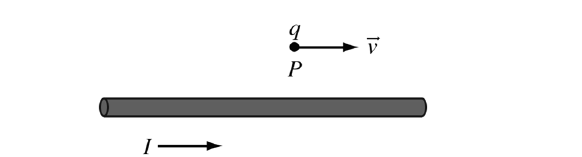
FIG. 3. The Magnetic Force question, designed by the authors of the paper.